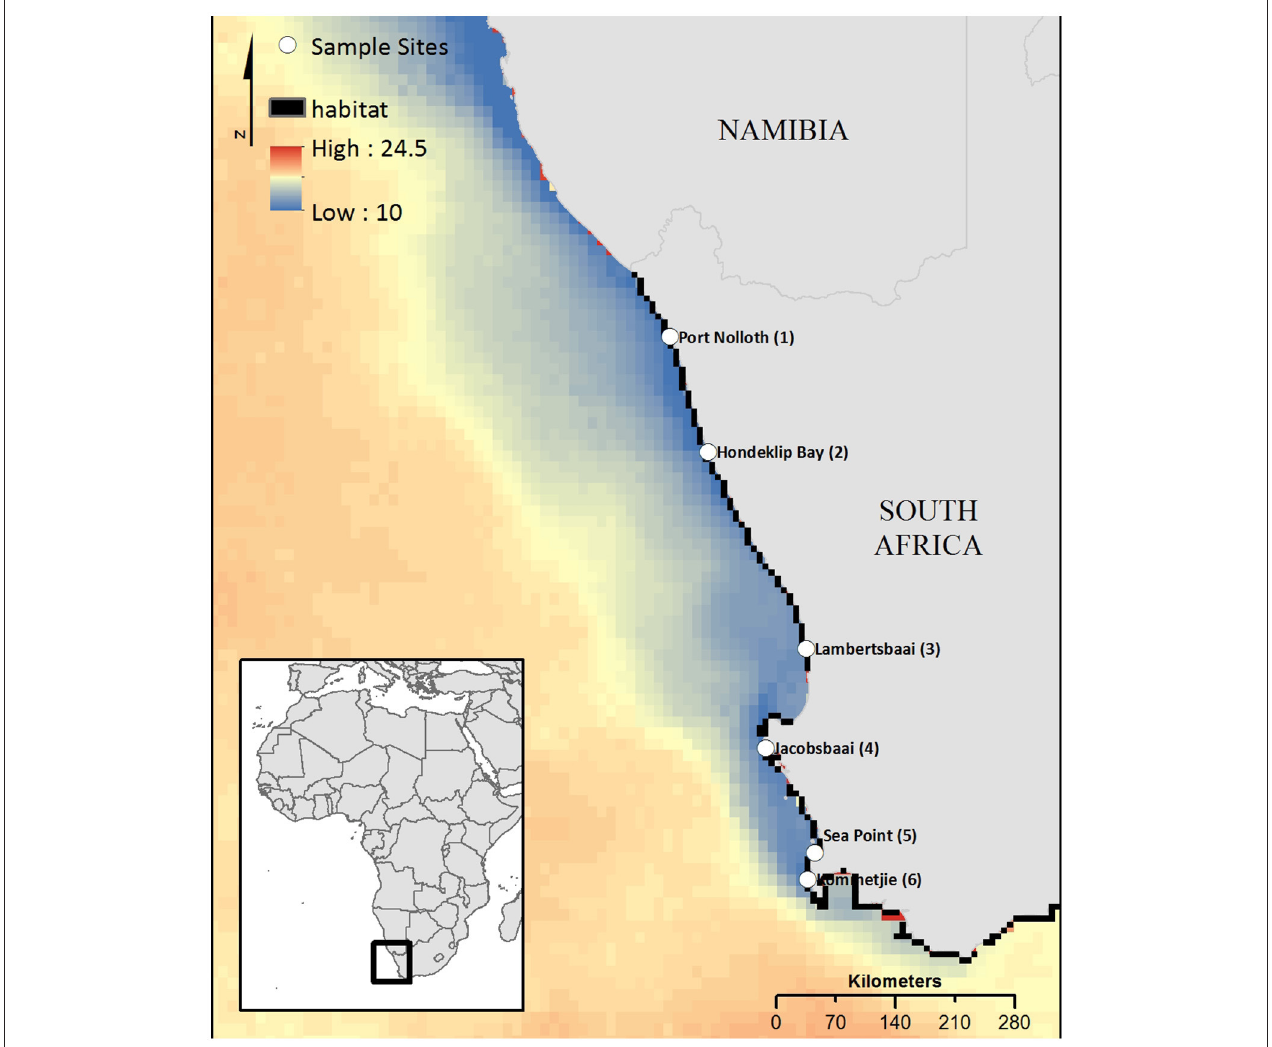
FIGURE 1 | South Africa’s west coast with the sampling locations and the study area used for biophysical modeling. Site names feature the site IDs, which are used in the network plots. Mean sea surface temperature illustrates temperature differences. Modeled habitat patches, including rocky coast, and mixed shore, are shown in